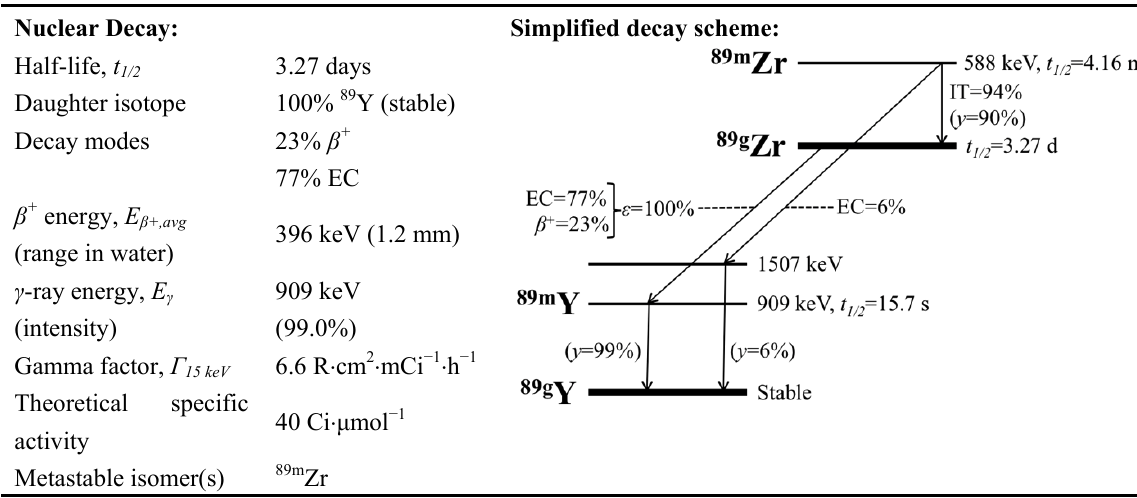
Table 1. Summary of chemical and nuclear decay properties of 89 Zr with a simplified decay scheme.